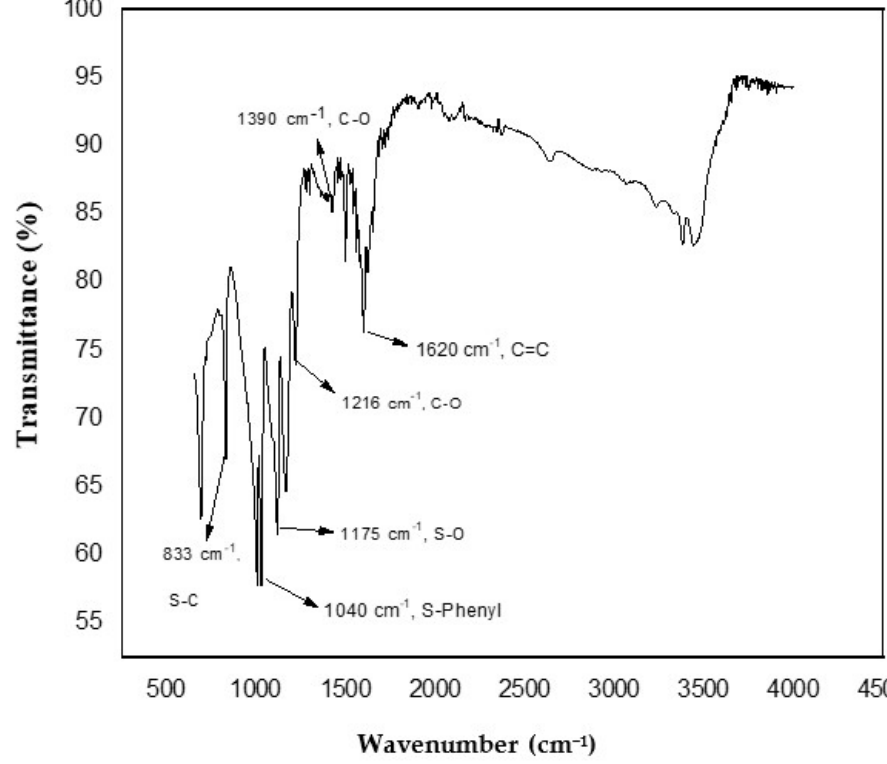
Figure 2. FTIR spectrum of sulfonated graphene oxide.